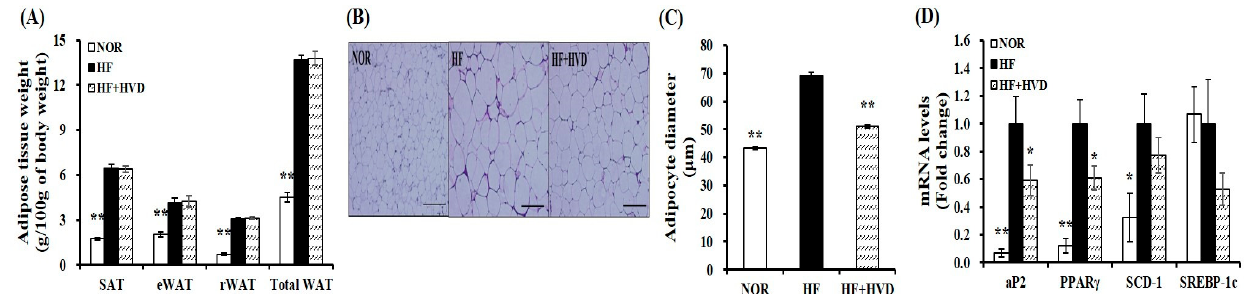
Figure 3. Effect of vitamin D supplementation on adipose tissue weight and adipocyte size. ( A ) White adipose tissue (WAT) weights. ( B ) Representative hematoxylin and eosin (H&E)-stained epidydimal sections (scale bars, 200 µ m; magnification, 400 × ). ( C ) Average adipocyte diameter of epididymal WAT (eWAT). ( D ) Gene expression of adipogenesis in eWAT. Gene expression of β -actin, as a reference gene was used for normalization, and data were presented as fold change compared to the HF group. Values are expressed as the mean ± SEM ( n = 9/group). NOR, 10% fat diet with 1000 IU vitamin D; HF, 60% fat diet with 1000 IU vitamin D; HF + HVD, 60% fat diet with 10,000 IU vitamin D. * p < 0.05; ** p < 0.01 compared to the HF